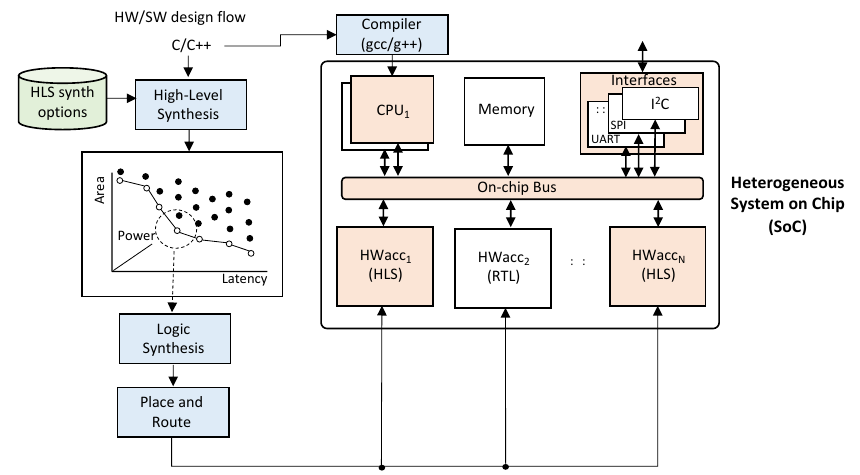
Figure 1. Overview of a typical heterogeneous SoC and its design